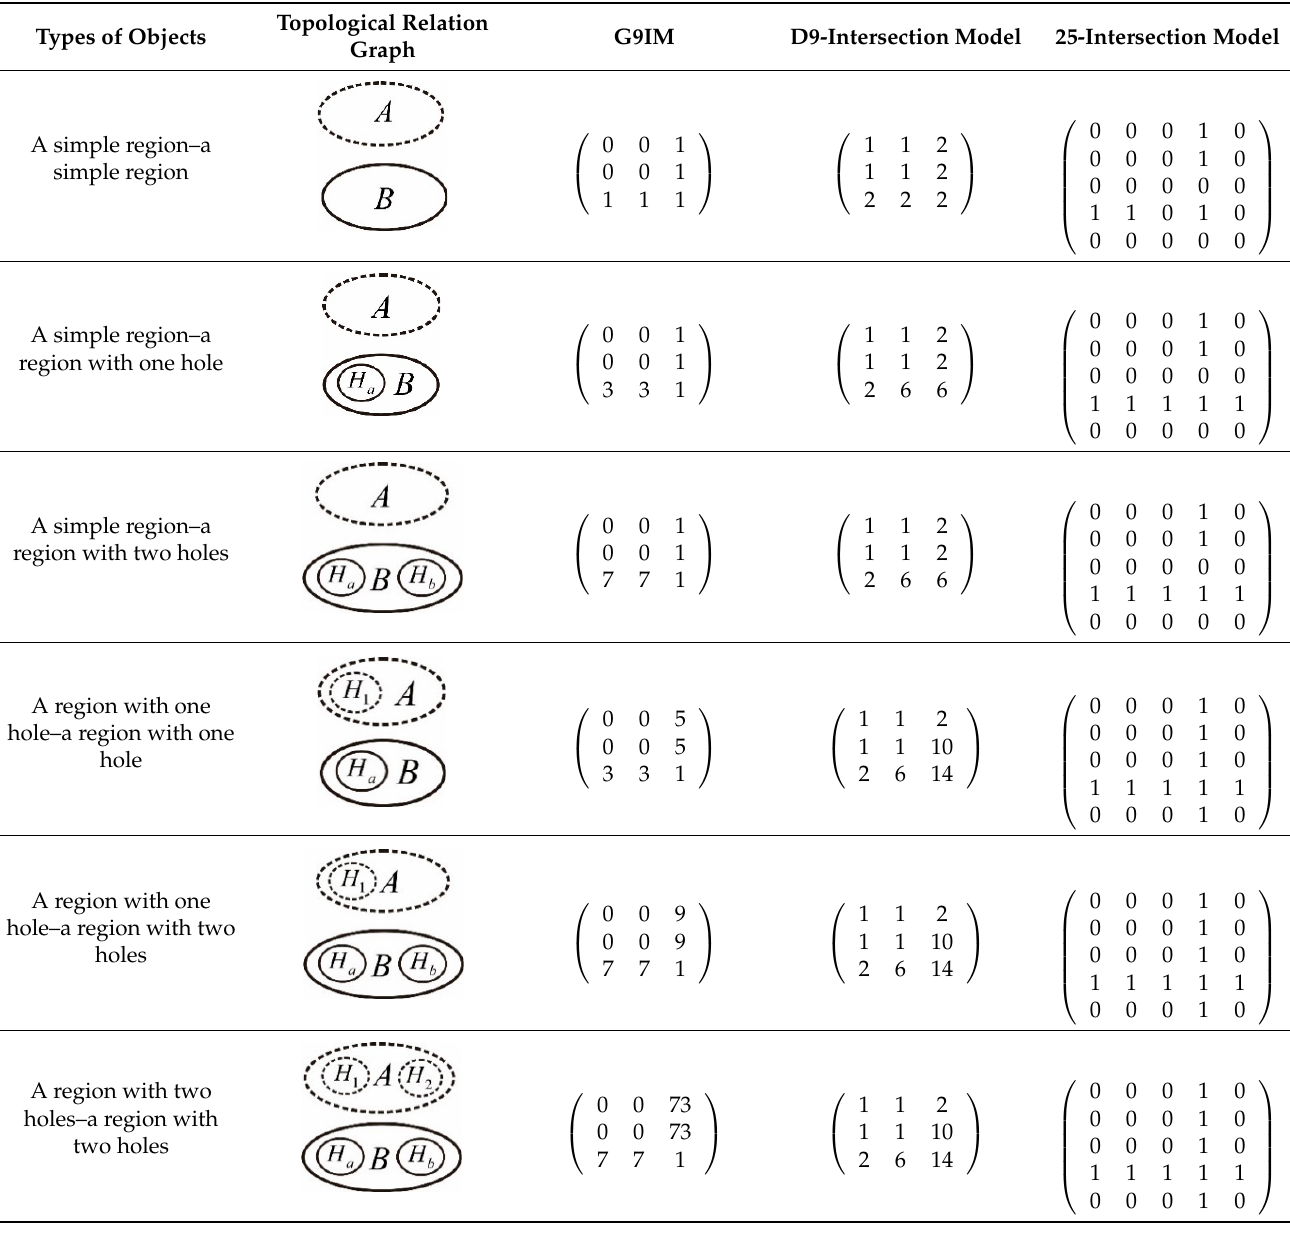
Table 3. Describing results of disjoints between different complexity objects by using three types of topological representation models.